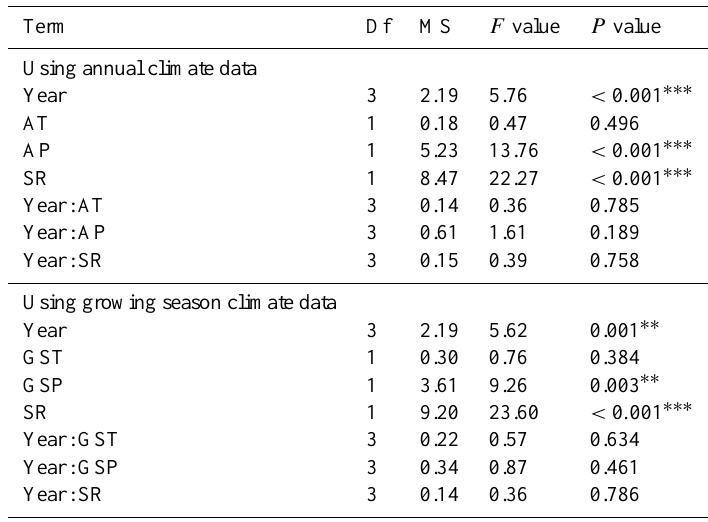
Table 4. Summary of ANCOVA for the effects of year, climate and species richness on aboveground net production (ANPP). ∗∗∗ P < 0 . 001; ∗∗ P < 0 . 01; ∗ P < 0 . 05.